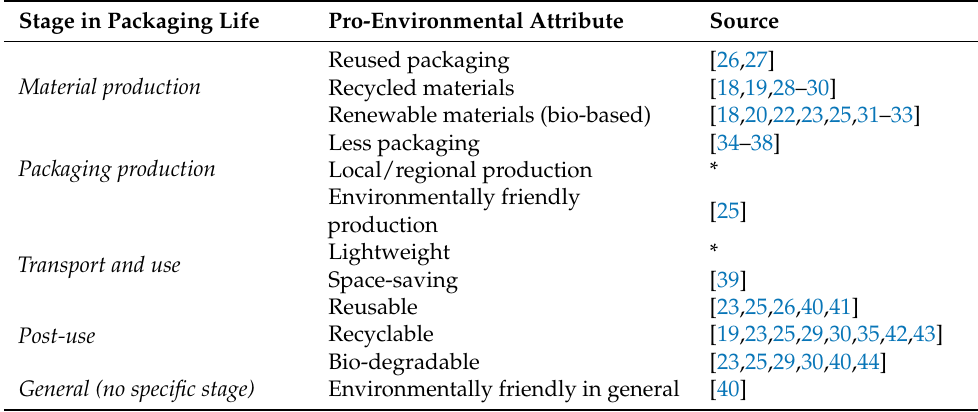
Table 1. Pro-environmental attributes of packaging solutions. Stage in Packaging